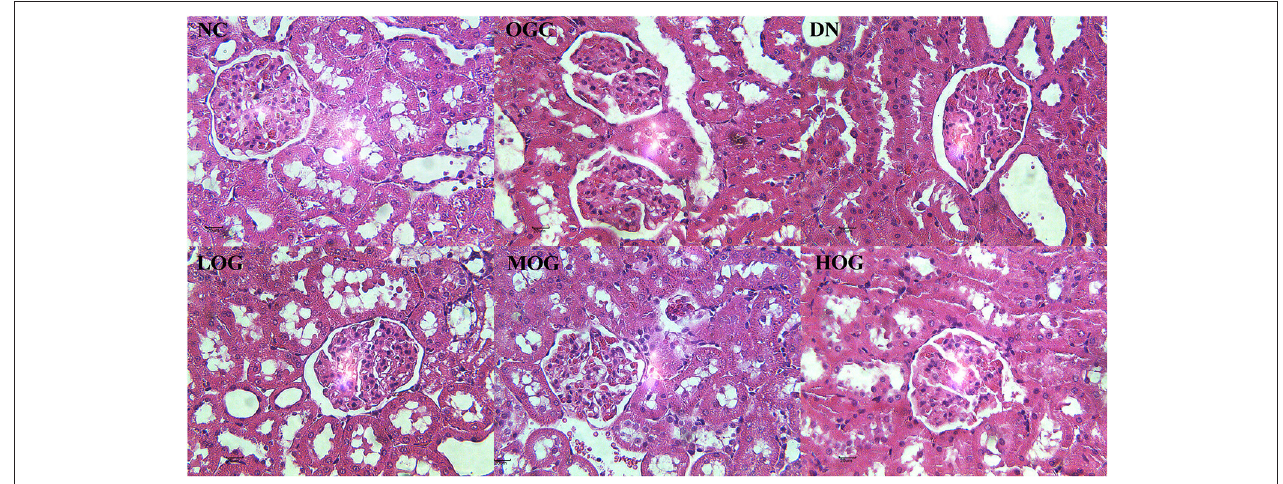
FIGURE 2 | Pathological changes of the kidney of the rats in each group. Scale bar: 20 µ m; original magnification 400 × .